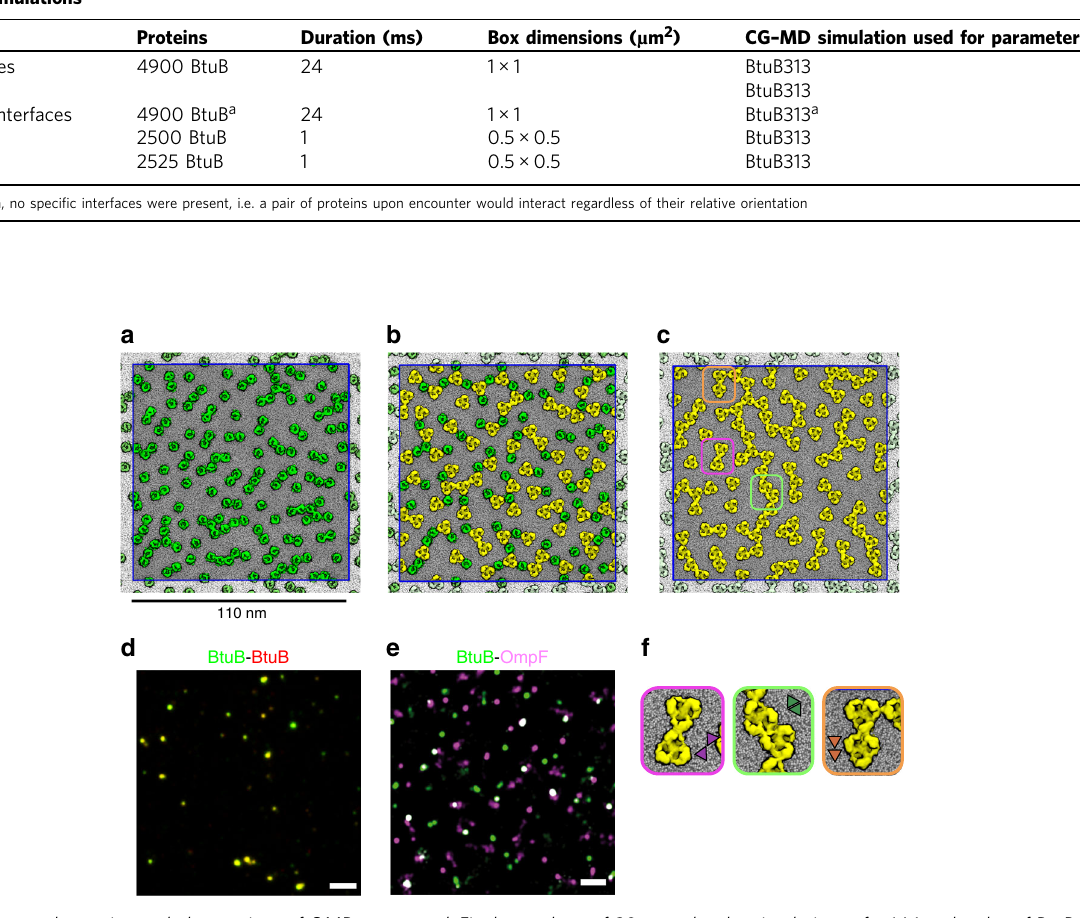
Fig. 1 Simulations and experimental observations of OMPs compared. Final snapshots of 20 μ s molecular simulations of a 144 molecules of BtuB (green); b 72 molecules of BtuB + 72 molecules of OmpF (yellow); and c 100 molecules of OmpF in a lipid bilayer (PE:PG 3:1) membrane and simulated at 323 K. For the OmpF system, the zoomed images ( f ) illustrate the three main con fi gurations of OmpF association observed in the simulations: tip-to-tip (purple box), base-to-base (green box) and base-to-top (orange box) interactions of adjacent OmpF trimers (see main text and ref. 2 ). Further